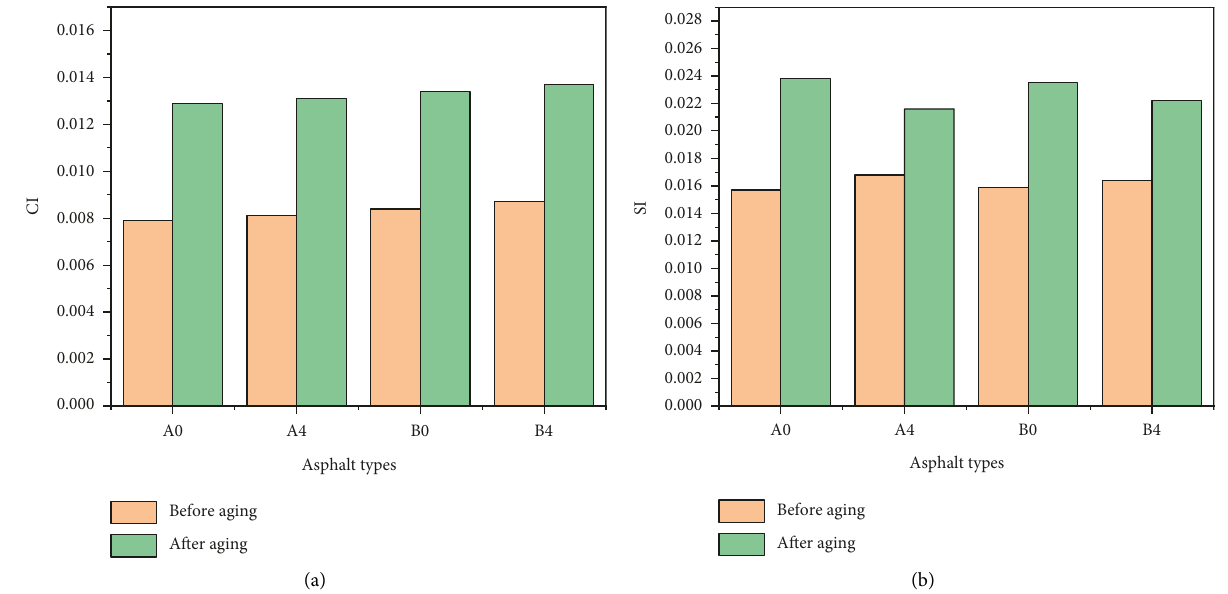
Figure 13: CI and SI before and after aging of the different bio-asphalts. (a) CI and (b)